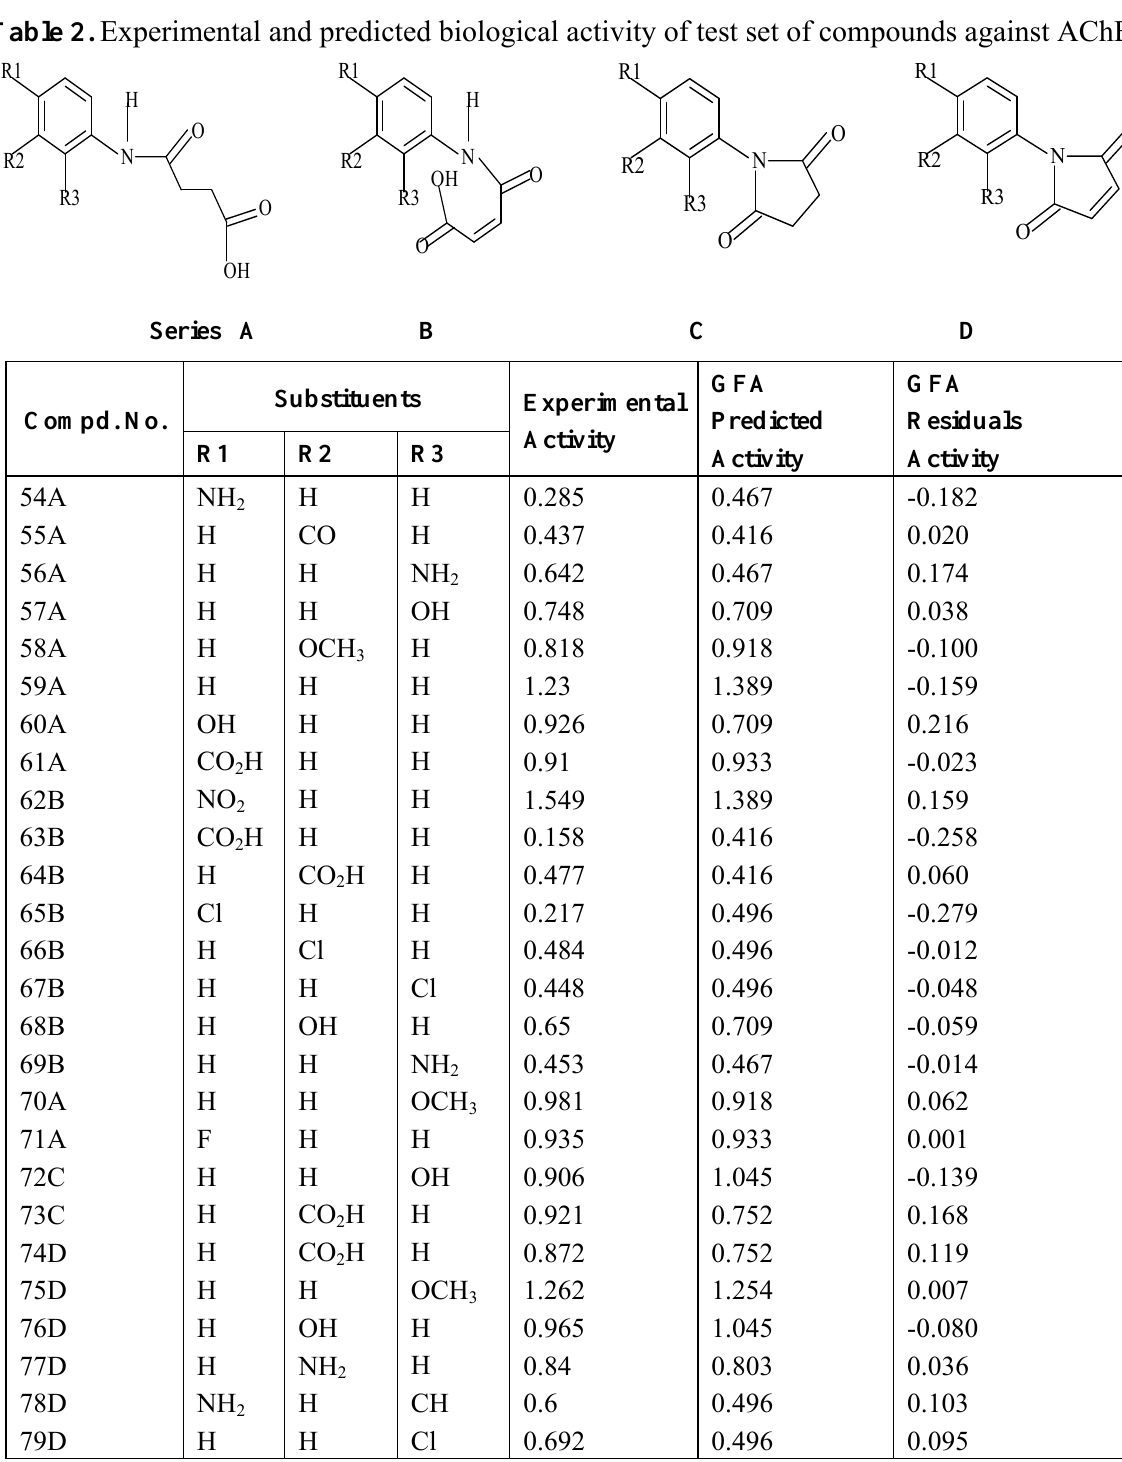
Table 2. Experimental and predicted biological activity of test set of compounds against AChE.